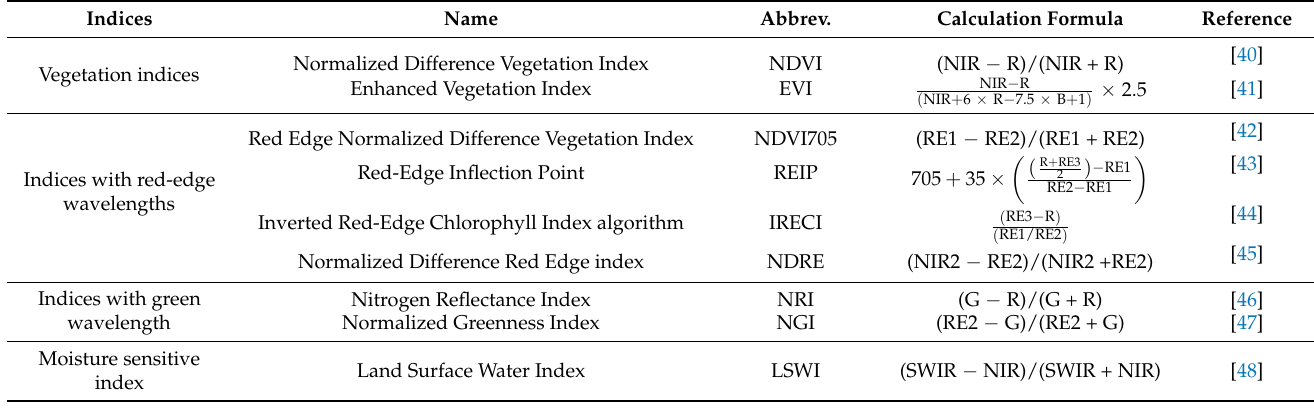
Table 1. Indices used as potential predictors of forage biomass and